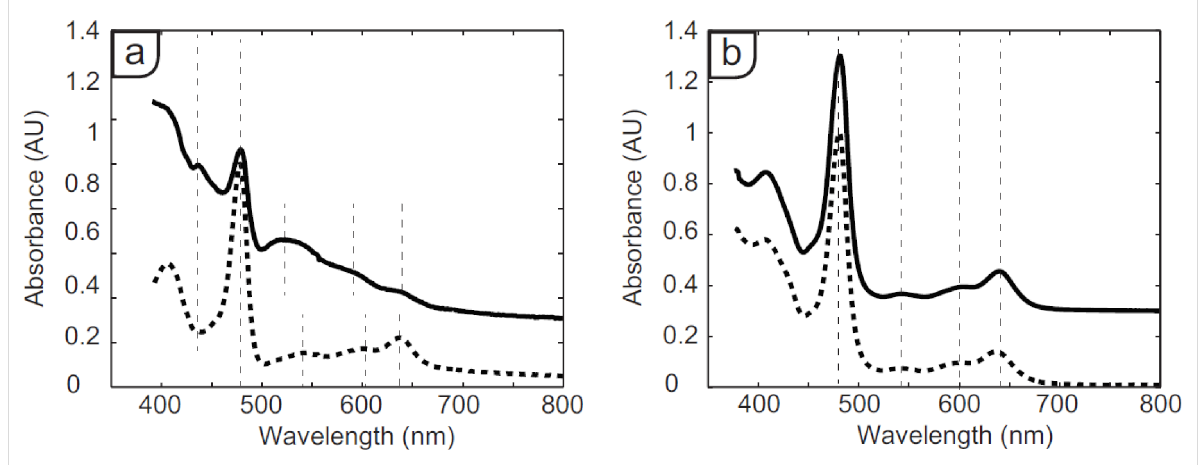
Figure 3: UV–vis spectra of sample (solid traces) and reference solutions (dashed traces of (a) MnTUPCl and (b) MnTUPOAc in 1-phenyloctane. The locations of main bands are indicated by narrow dashed vertical lines.